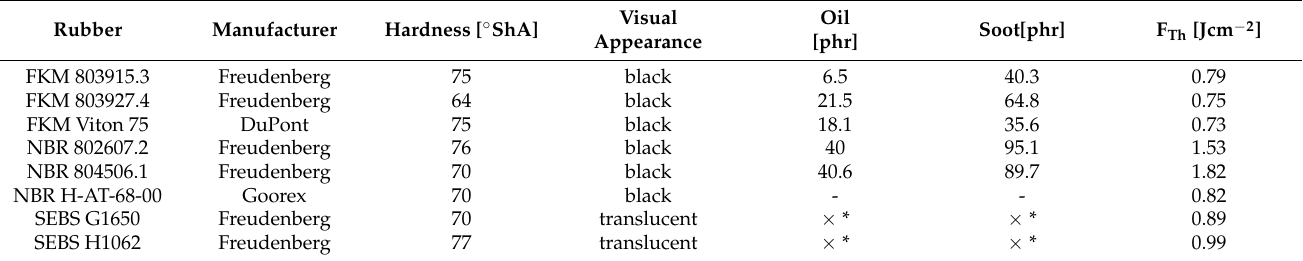
Table 1. Material characterization and threshold fluences F Th used in this work. * Not